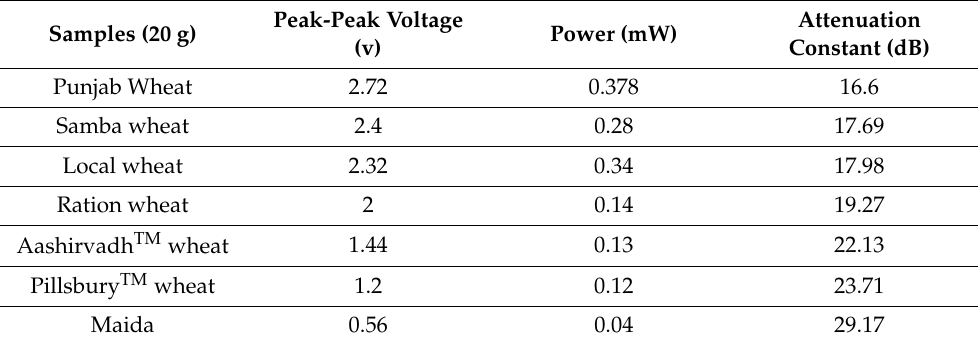
Figure 2. ( a ) Attenuation constant and ( b ) absorbance vs. weight of sample in mg. The blue colour line indicates attenuation constant and the brown colour line indicates absorbance. Linear equations for attenuation constant by the waveguide method from the graph as y = 0.84057 x + 2.0067, where the slope of the graph is m = 0.84057. The squares and circles represent the data for attenuation constant and absorbance respectively. Table 2. Attenuation Constant of Different Variety of Wheat